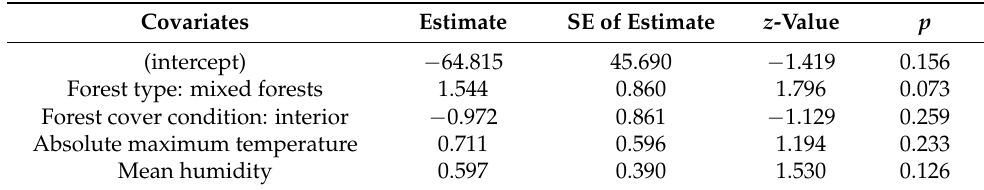
Table 8. Xyleborinus saxesenii . Effectiveness of alcohol in attracting individuals of the species, accounting for the effects of habitat and meteorological covariates considered in the negative binomial regression model.